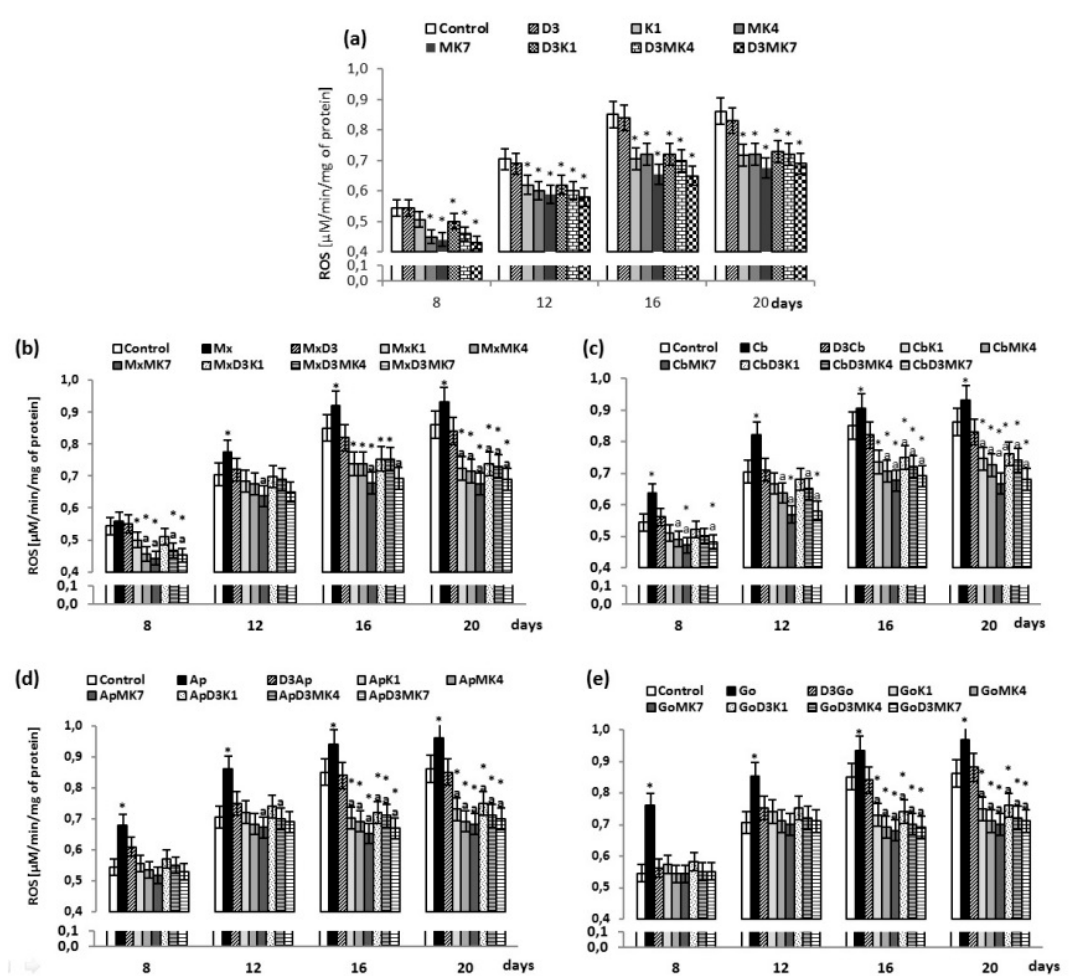
Figure 1. Reactive oxygen species (ROS) level in osteoblasts after incubation with hydroxyapatites and treated with vitamins D3, K1, MK4, and MK7 after 8, 12, 16, and 20 days. The results are expressed as the µ M/min/mg of protein and are shown as the mean ± SD ( n = 5). The values for the control cells and the treated cells were significantly different according to unpaired Student’s t -test. * Statistically significant differences versus control, p < 0.05; ( a ) statistically significant differences versus group hydroxyapatites (Mx (Maxgraft), Cb (Cerabone), Ap (Apatos), Go (Gen-Os), respectively for graphs ( b – e )); p < 0.05; .